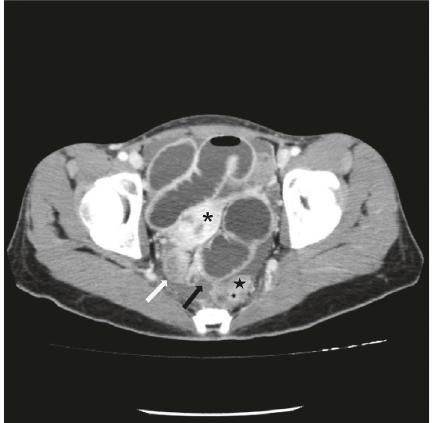
Figure 1: Axial CT image shows distended proximal bowel loop and collapsed distal loop (white arrow) at a transition zone (black arrow) between the uterus (asterisk) and the rectum (star).